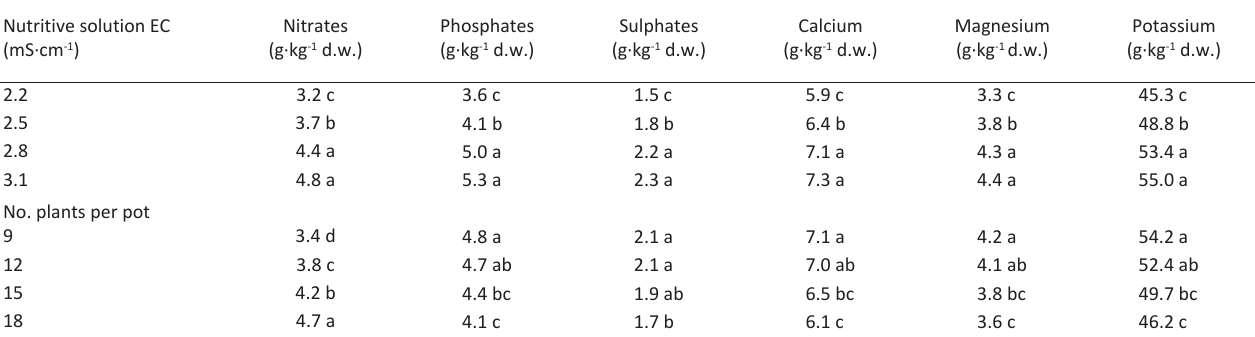
Table 6 - Basil leaves chemical composition Nutritive solution EC (mS·cm -1 )